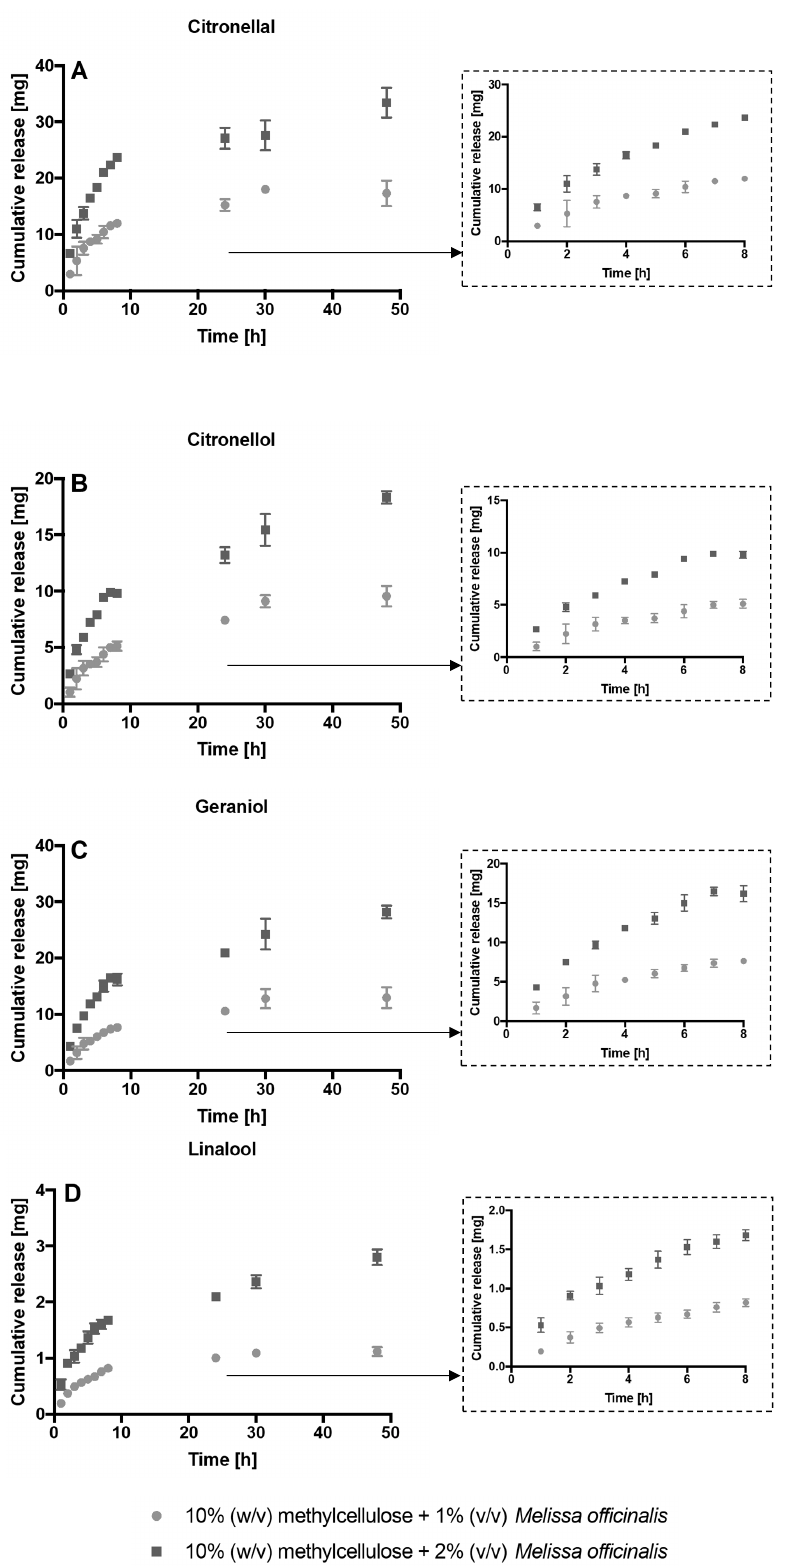
Figure 3. Cumulative release in milligrams of citronellal ( A ), citronellol ( B ), geraniol ( C ) and linalool ( D ) from 10% ( w / v ) methylcellulose with 1% ( v / v ) Melissa officinalis (circle), 10% ( w / v ) methylcellulose with 2% ( v / v ) Melissa officinalis (square). A zoom of the cumulative release between 0 and 8 h is also shown in the dashed rectangles.